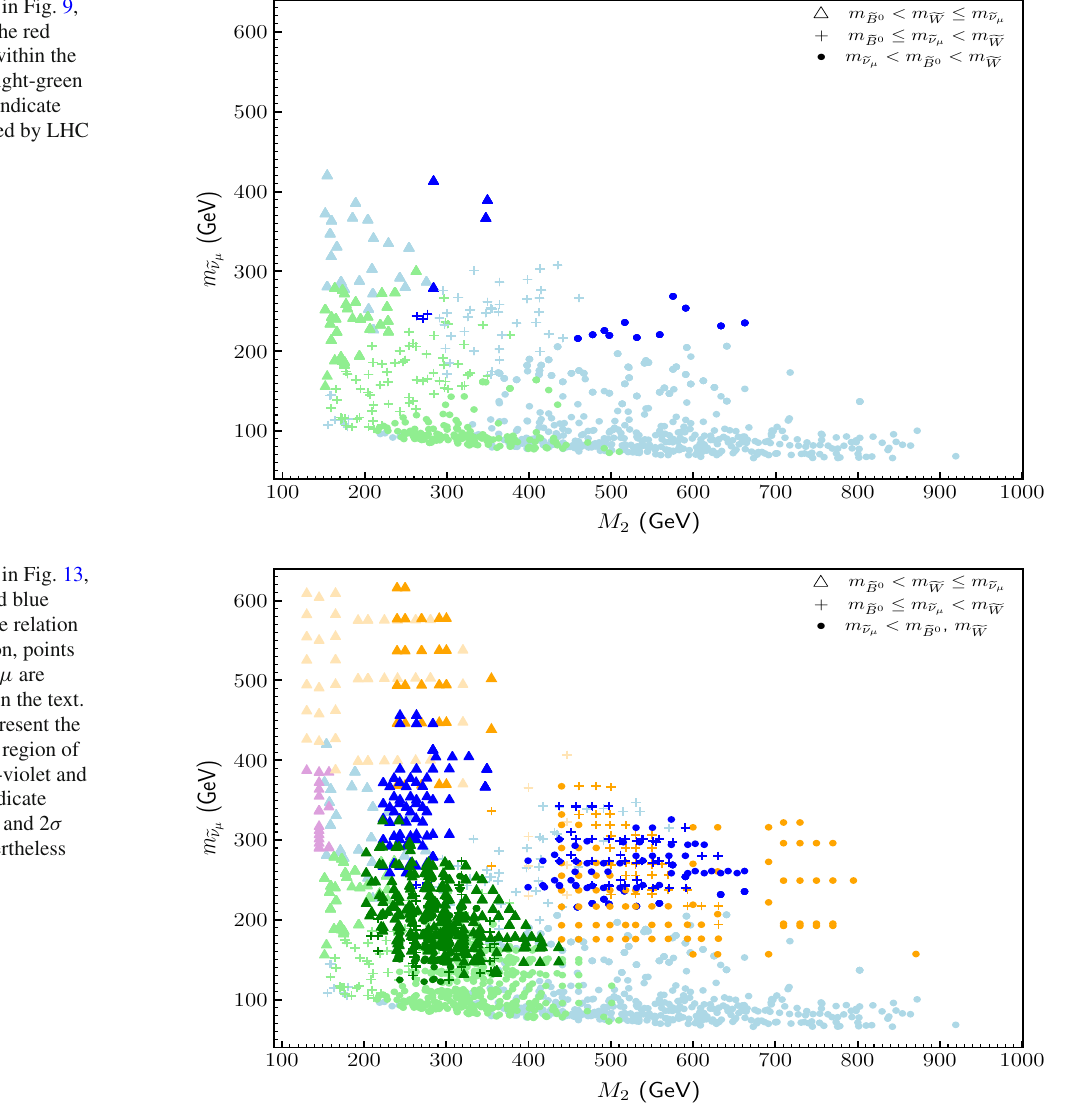
Fig. 14 The same as in Fig. 13, but allowing green and blue points not fulfilling the relation M 2 = 2 M 1 . In addition, points with a larger value of μ are allowed as discussed in the text. The orange colors represent the latter points in the 2 σ region of (cid:3) a μ in Eq. (1). Light-violet and light-orange colors indicate those points in the 1 σ and 2 σ regions excluded nevertheless by LHC